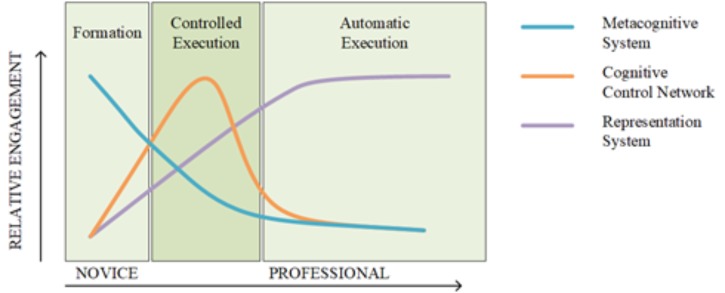
The framework of behavioral learning of Chein and Schneider (2012).